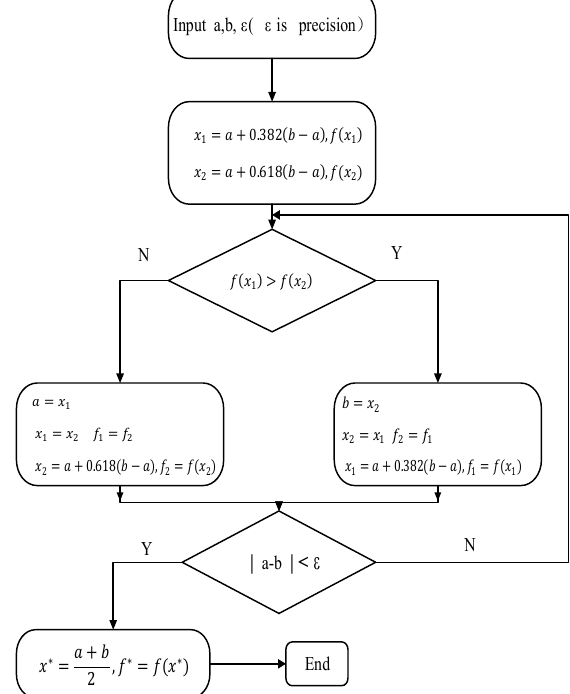
Machines 2022 , 10 , x FOR PEER REVIEW Figure 9. Quick search method search process. Figure 9. Quick search method search process.